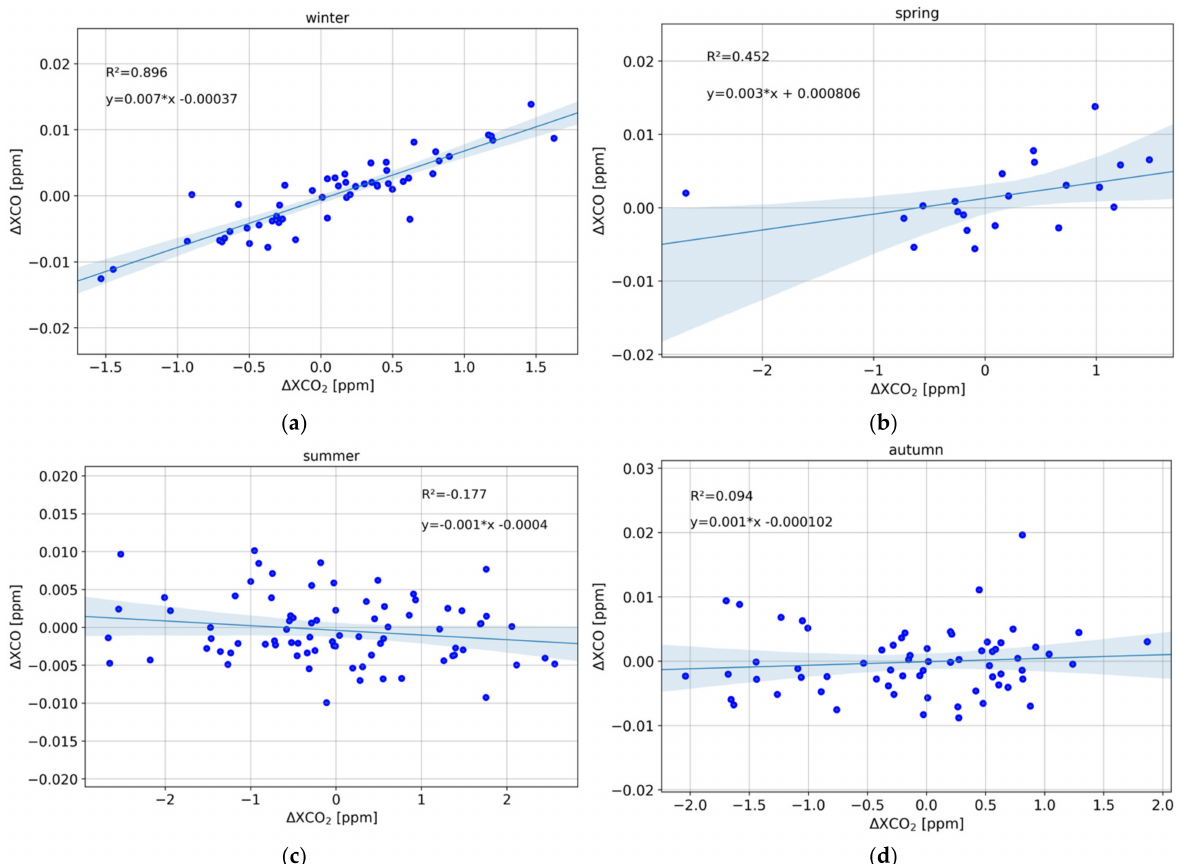
Figure 7. Correlation between collocated ∆ XCO and ∆ XCO 2 for winter ( a ), spring ( b ), summer ( c ) and autumn ( d ), and the resulting linear correlation line. The confidence interval is shown in the faded light-blue